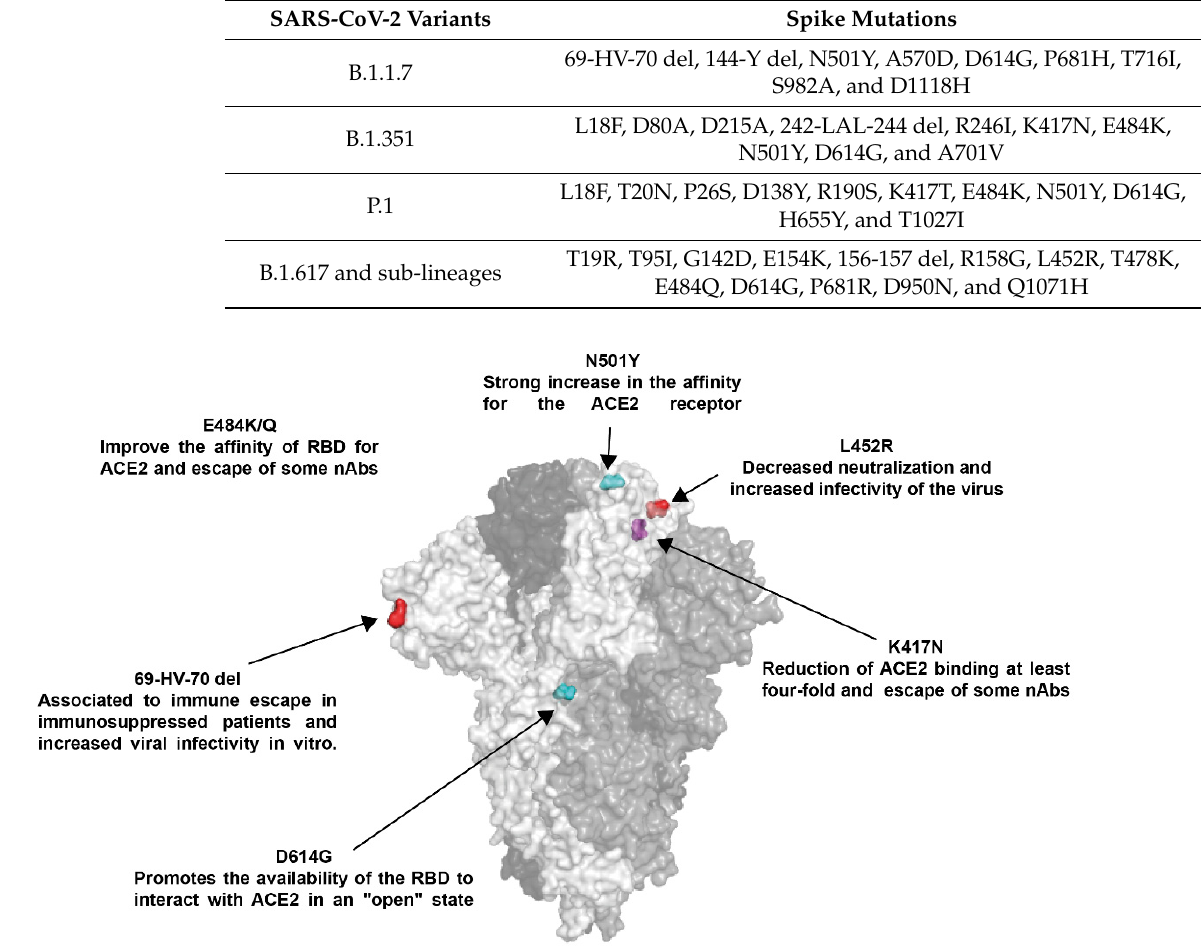
Figure 2. Main mutations in S glycoprotein that regulate viral transmissibility and neutralization. Structure of the S glycoprotein in a trimeric conformation (PDB: 6VXX); each monomer is shown in a different shade of gray, mutation sites are only shown for one monomer (light grey), and the colors used are to visualize one mutation for another. Table 1. Mutations in S glycoprotein of SARS-CoV-2 variants.